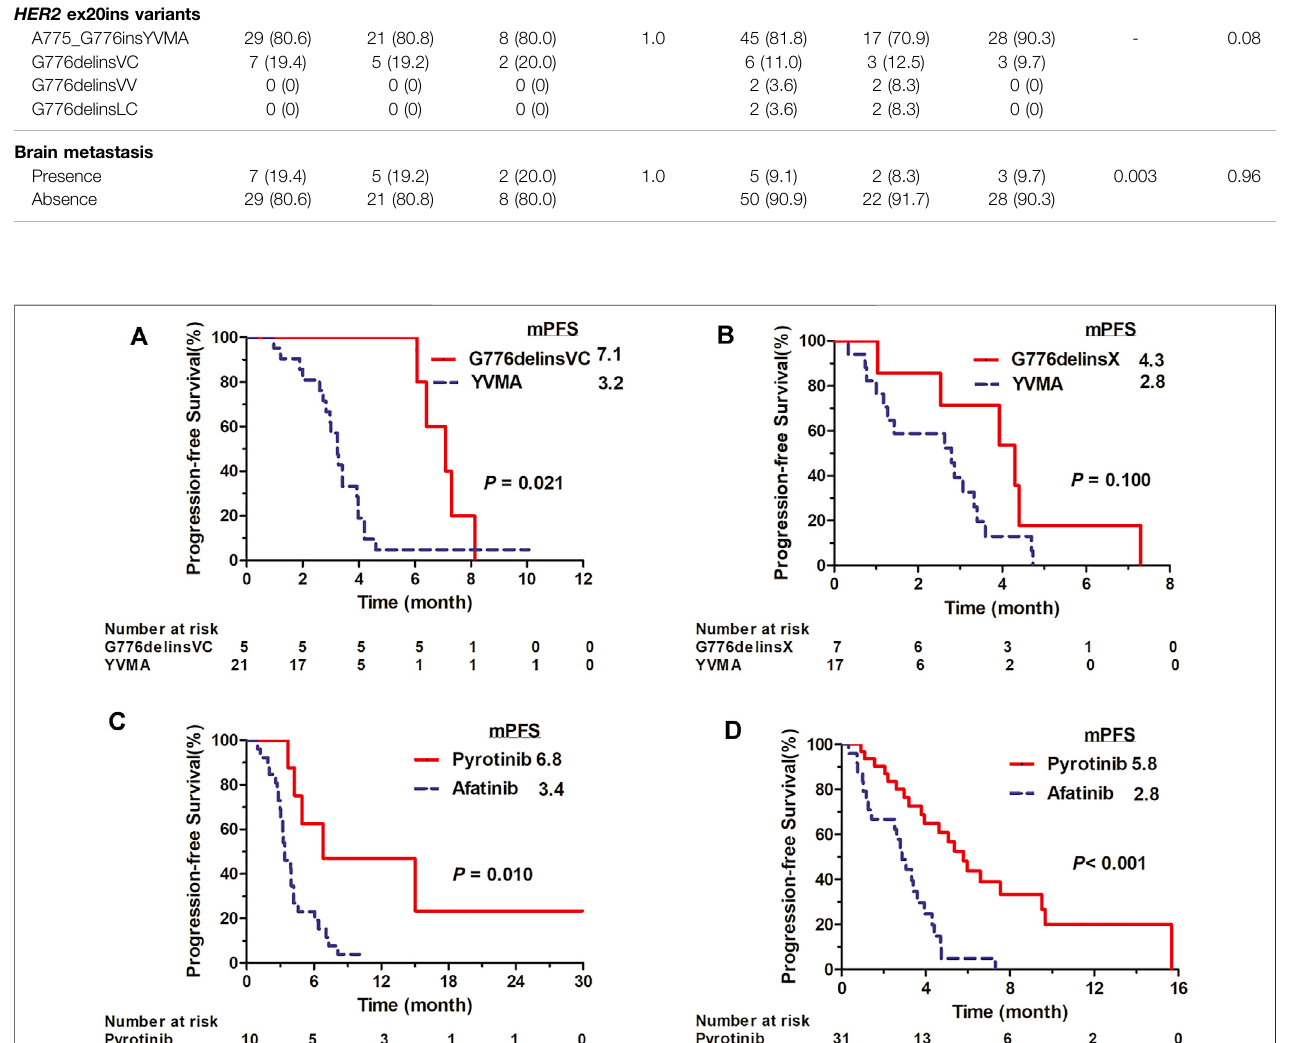
Frontiers in Pharmacology |